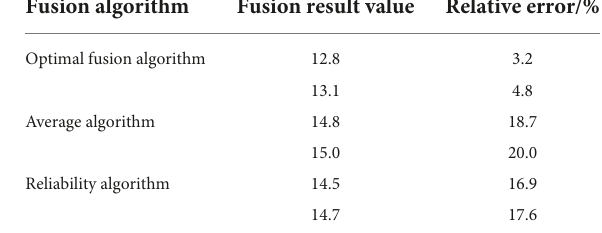
TABLE 4 Comparison of fusion